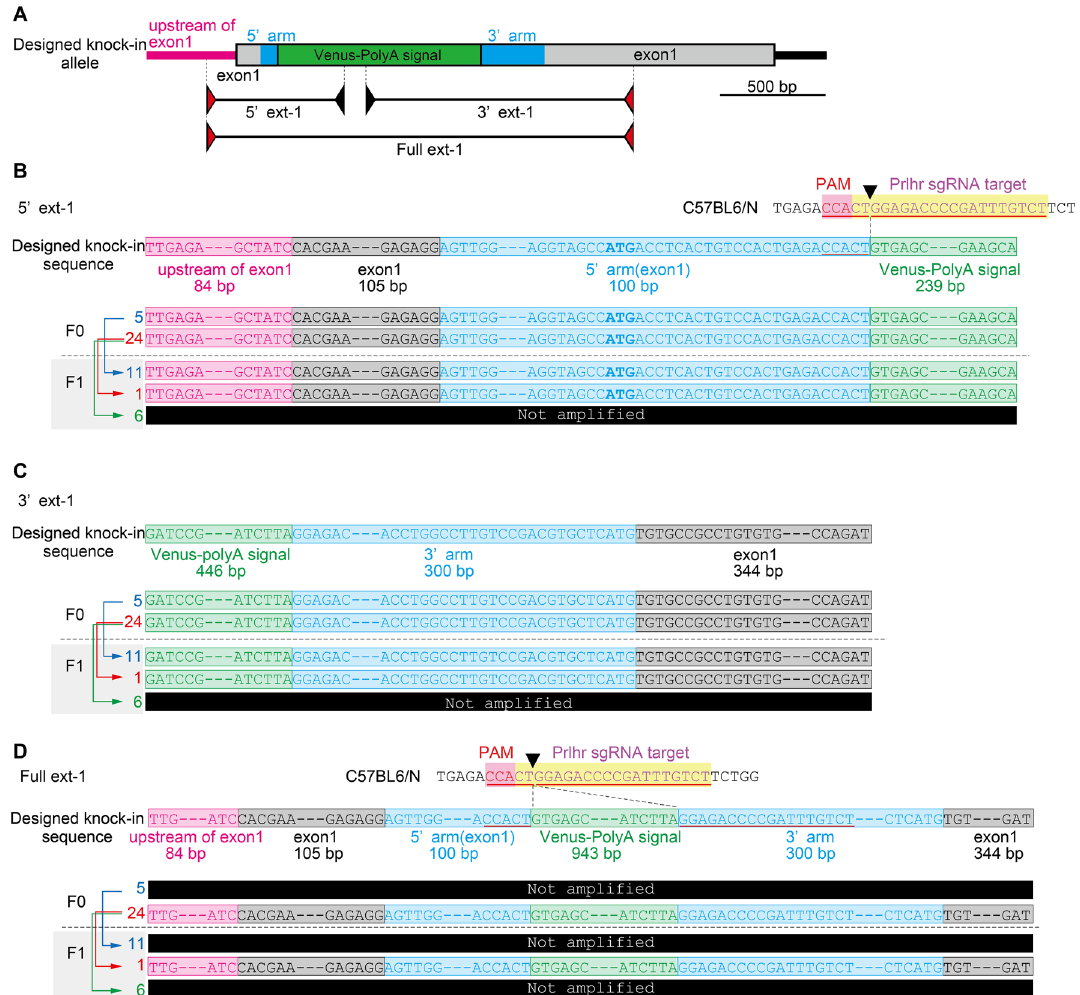
Figure 5. Analysis of genomic sequencing in the F0 and F1 generations. ( A ) Schematic representation of the designed Prlhr knock-in locus and primer sets for PCR amplification (primer external to the targeting vector and internal primer pairs, 5’ext-1 and 3’ext-1; primers external to the targeting vector pair, Full ext-1). Red and black arrows show the primer external to the targeting vector and internal primer, respectively. Sequence analysis for the PCR products of the 5’ ext-1 ( B ), 3’ ext-1 ( C ), and Full ext-1 ( D ). Blue, red, and green arrows show the parent–offspring